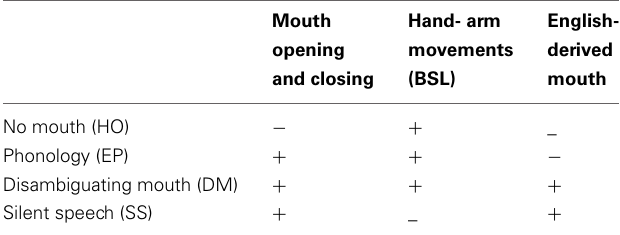
Table 4 | Characteristics of stimuli in fMRI experiment.